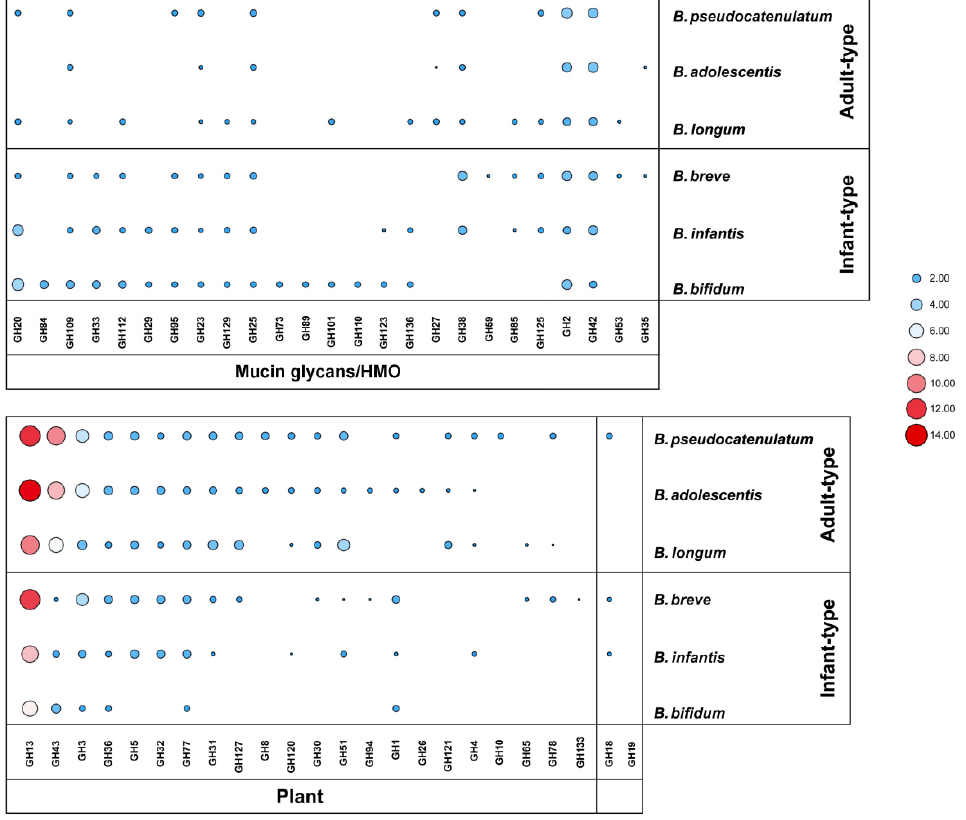
Figure 3. Distribution of average gene copy number of GHs in Bifidobacterium .